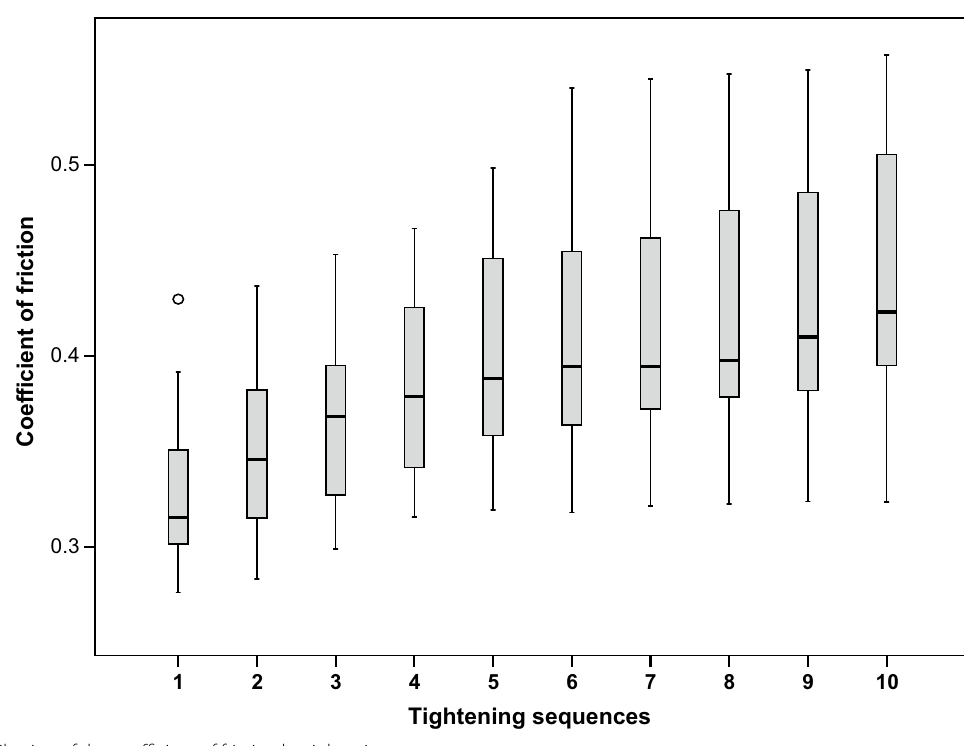
Fig. 6 Distribution of the coefficient of friction by tightening sequence